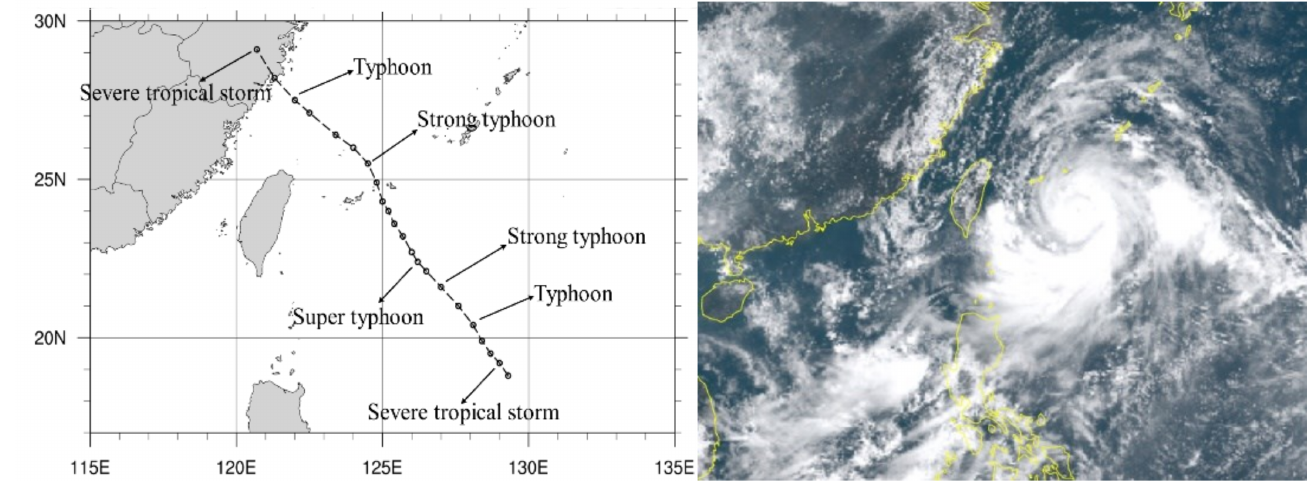
Figure 1. The best track of Lekima from 2100 UTC on 6 August to 0000 UTC on 10 August provided by Tropical Cyclone Data Center of China Meteorological Administration ( left panel ); the Himawari-8 true color image of Lekima at 0000 UTC on 6 August provided by Japan Aerospace Exploration Agency Himawari Monitor P-Tree System ( right panel